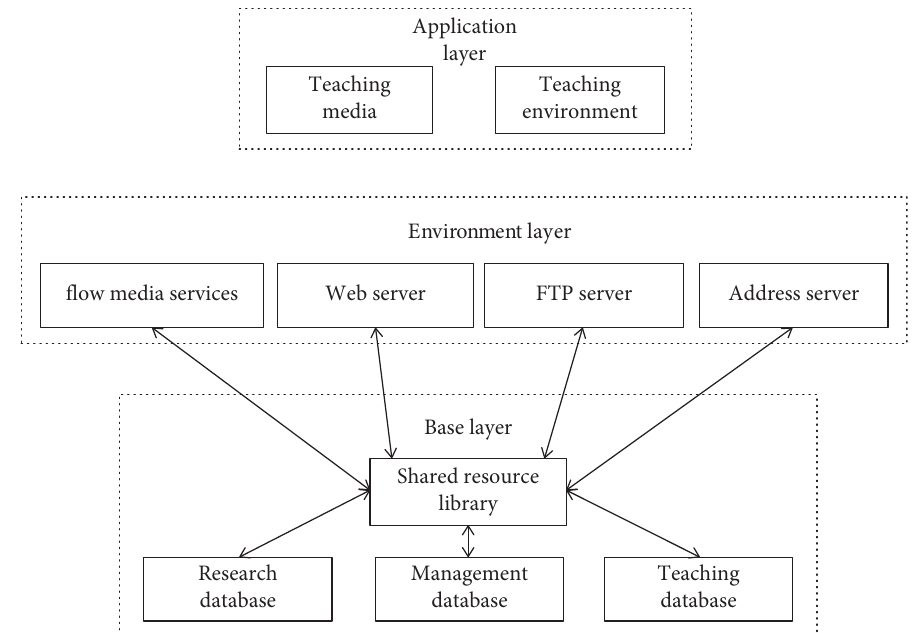
Figure 8: Model building